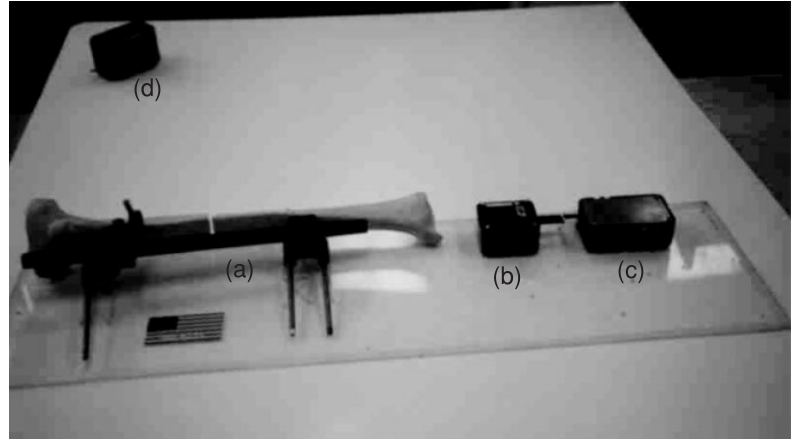
Figure 6 The developed smart bone fixation device and the remote sensing system, where (a) is the smart bone fixation device, (b) is the optoelectronic circuit, (c) is the wireless RF transmitter, and (d) is the wireless RF receiver and